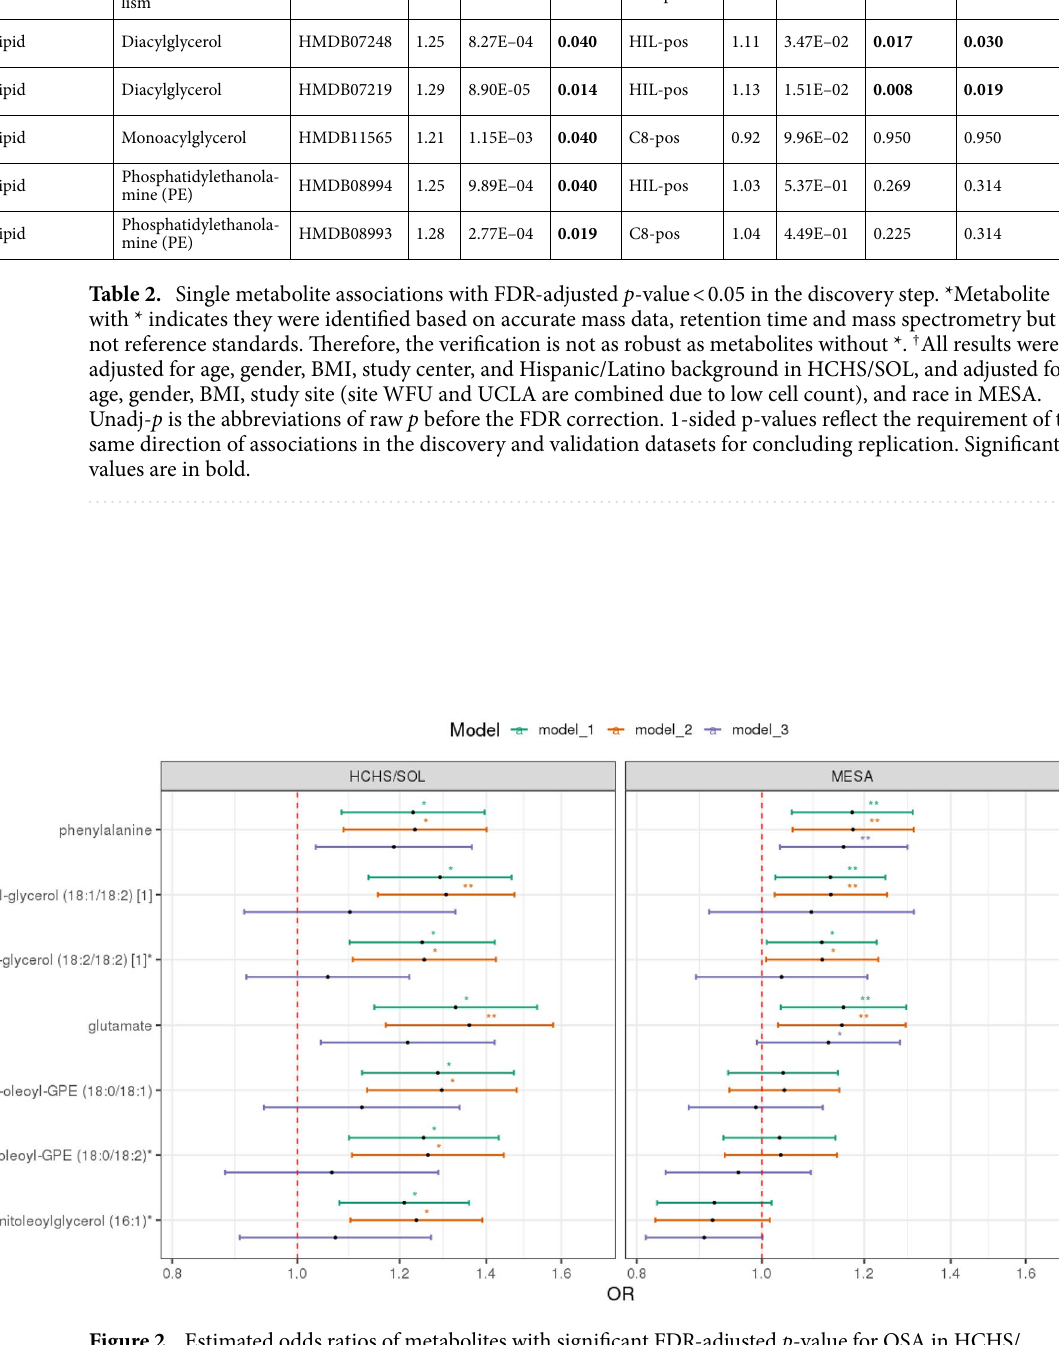
Figure 2. Estimated odds ratios of metabolites with significant FDR-adjusted p -value for OSA in HCHS/ SOL and in MESA. *indicates FDR p < 0.05 in HCHS/SOL and one-sided p < 0.05 in MESA. **indicates FDR p < 0.01 in HCHS/SOL and one-sided p < 0.01 in MESA. In HCHS/SOL: Model 1 adjusted for age, gender, center, background, and BMI. Model 2 adjusted for age, gender, center, background, BMI, alcohol use, smoking status, physical activity and diet (AHEI 2010). Model 3 adjusted for age, gender, center, background, BMI, alcohol use, smoking status, physical activity, diet, diabetes, hypertension, fasting glucose, fasting insulin, HOMA IR, HDL, LDL, total cholesterol, triglycerides, systolic blood pressure and diastolic blood pressure. In MESA: Model 1 adjusted for age, gender, BMI, study site (site WFU and UCLA are combined due to low cell count), and race. Model 2 adjusted for age, gender, BMI, study site, race, alcohol use and smoking status. Model 3 adjusted for age, gender, BMI, study site, race, alcohol use, smoking status, hypertension indicator, fasting glucose, HDL, LDL, cholesterol, triglycerides, systolic blood pressure and diastolic blood